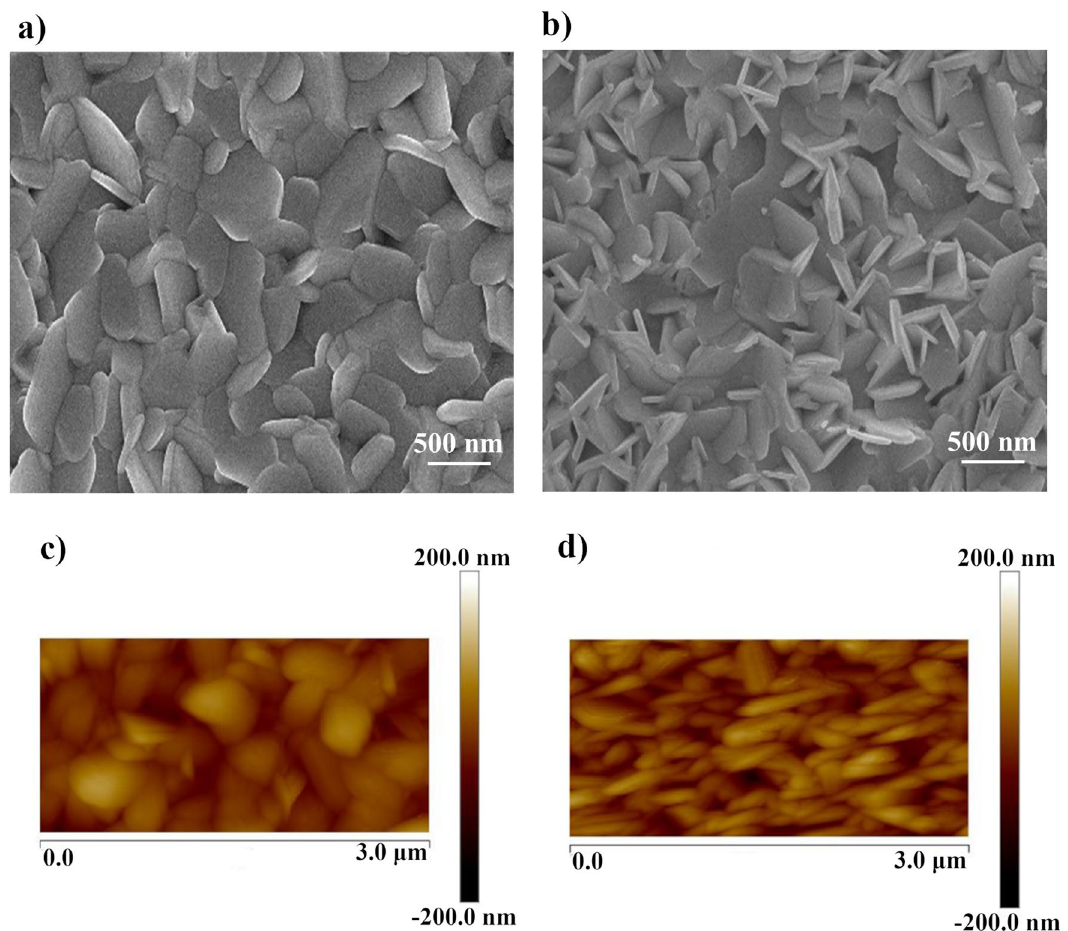
Figure 3. Top surface SEM images and AFM images of PbI 2 films obtained from iodination of chemically deposited PbS films at ( a , c ) 120 and ( b , d ) 155